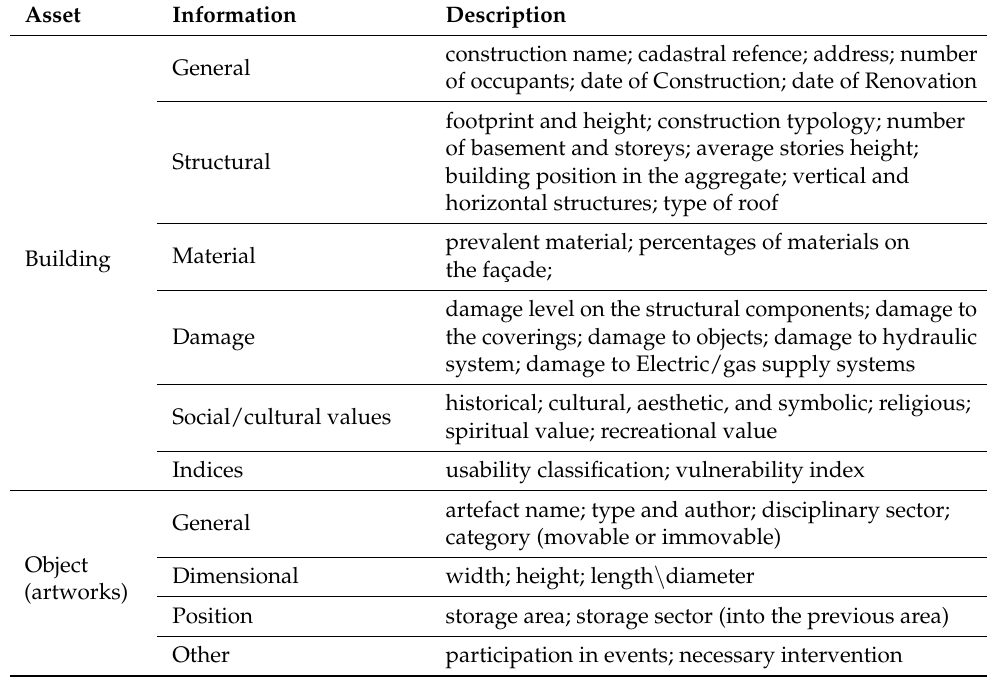
Table 6. Information contained in HArIS and available for the DSS.